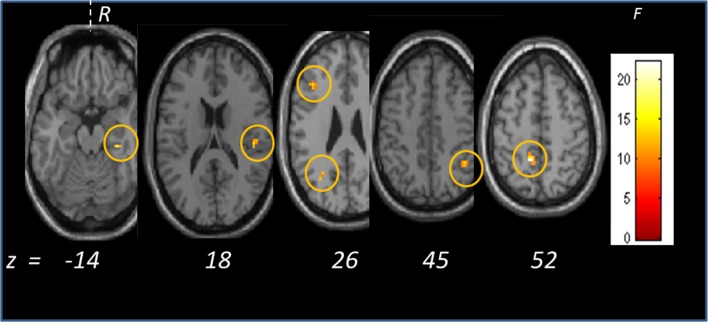
General effect of the odor stimulation on the group of teenagers from the three sites in Italy.The olfactory stimulation induced activation in scattered areas including precuneus, parahippocampal gyrus, insula, middle frontal and temporal gyrus and inferior parietal lobule. The statistical F-value is color coded (F[2,10], p < .005).